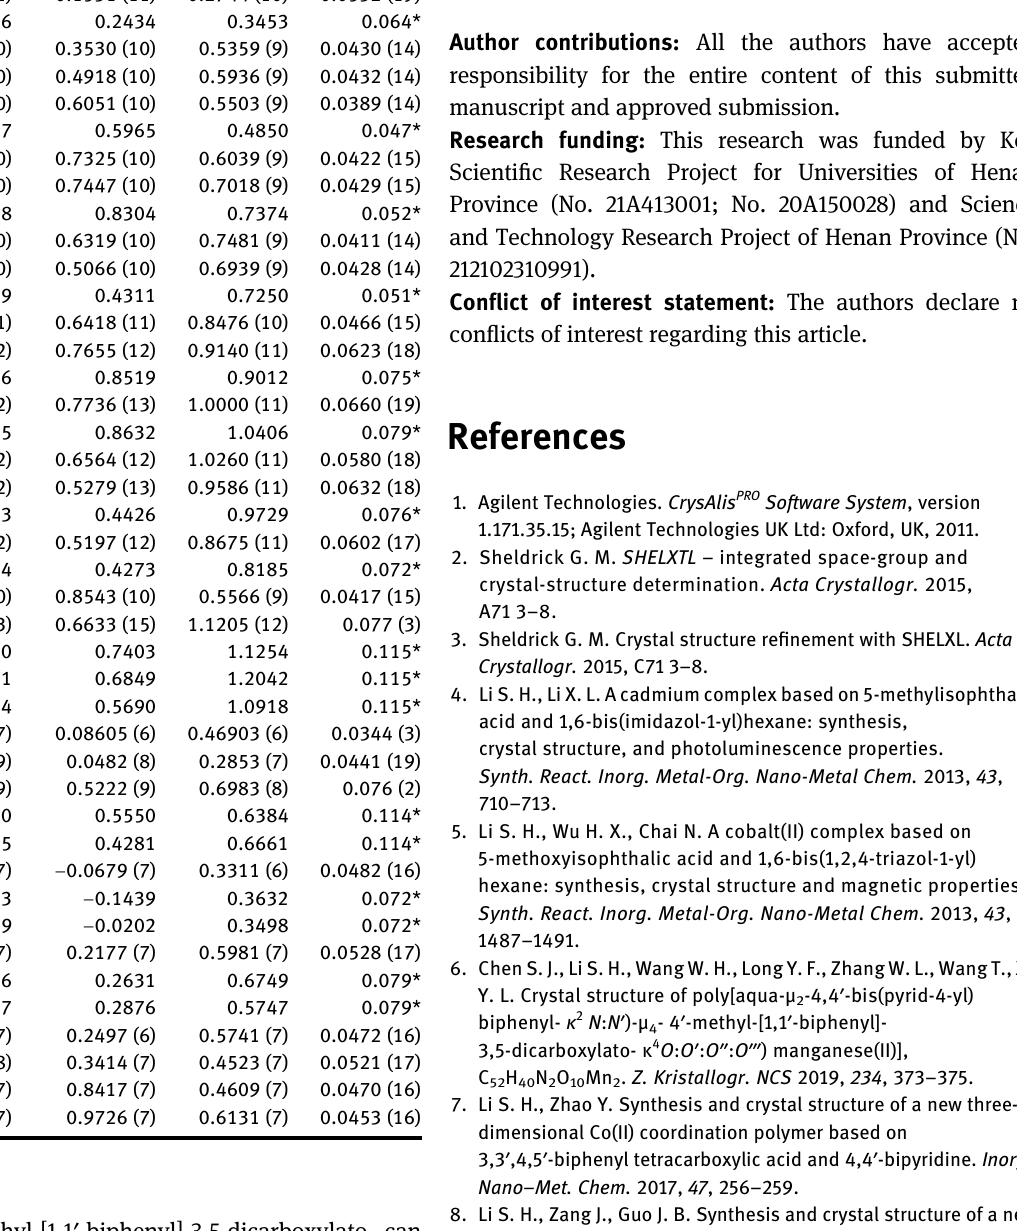
In the title complex, there are one Cd(II) ion, two coordinated water molecules one mbdc ligand, and one half of the 4,4 ′ -bipyridine ligand, and finally one uncoor- dinated water molecule in the asymmetric unit (see the Figure). The cadmium atom Cd1 is seven-coordinated by four O atoms from the mbdc ligands, two water ligands, and one N atom from the 4,4 ′ -bipyridine ligand from the axial positions (see the Figure). The Cd – N bond length is 2.287(7) Å and the Cd – O ones are in the range of 2.283(6) to 2.634(6) Å.